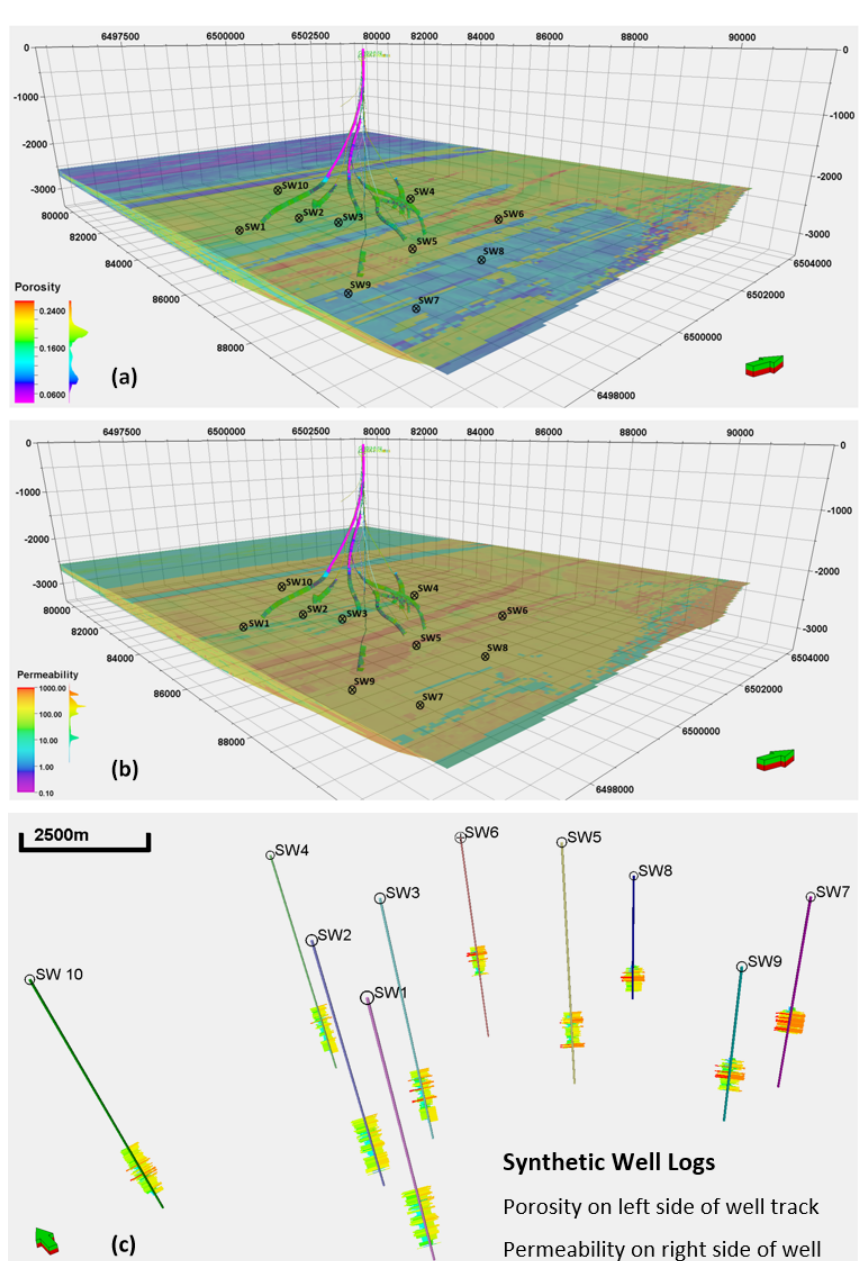
Figure 9. Synthetic well forward stratigraphic-based porosity and permeability models. The average separation distance between wells is about